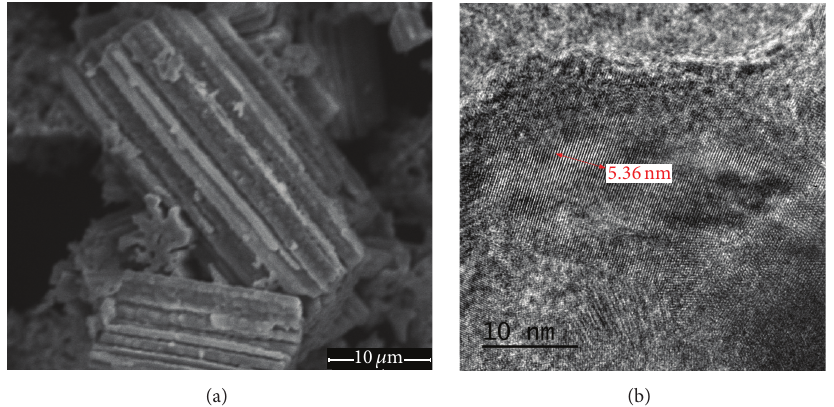
Figure 2: The morphology of Zn 3 Nb 2 O 8 : (a) SEM micrographs; (b) HRTEM.